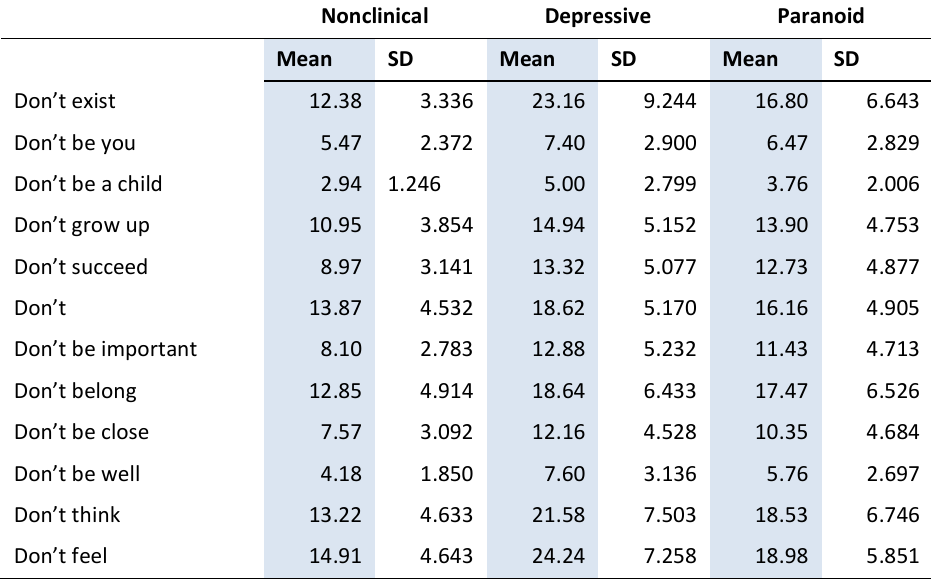
Table 5: Descriptive group indicators on studied variables Nonclinical Depressive Paranoid Mean SD Mean SD